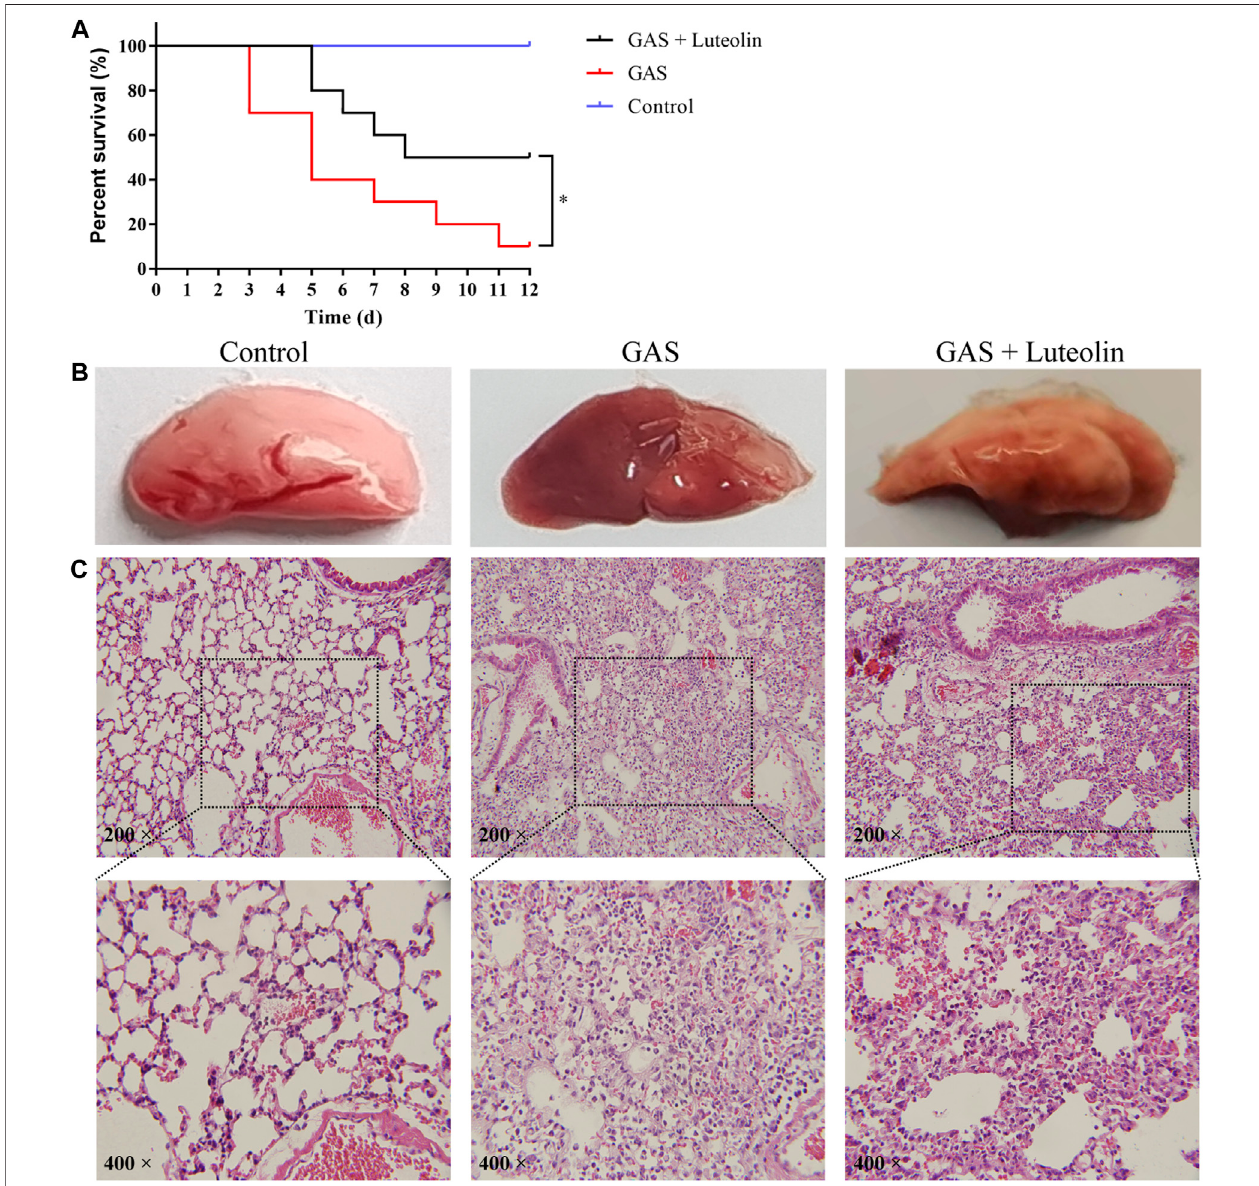
FIGURE 6 | Luteolin protects mice against GAS pneumonia. (A) The in fl uence of luteolin on the mortality of GAS-infected mice. GAS, GAS + luteolin, and Control groups of mice inhaled 1 × 10 8 CFU dose of GAS via a nebulized lung delivery, and the mortality of mice was supervised for 12 days. Data are representative of three independent experiments ( n = 10 mice in the per group) and are shown as mean ± SD (Kaplan-Meier tests). * p < 0.05 versus control. (B,C) Pathologic and histopathological changes in lung tissue. Lung tissue from GAS-infected mice (7 days after infection). Lung tissue was stained with H&E (original magni fi cation